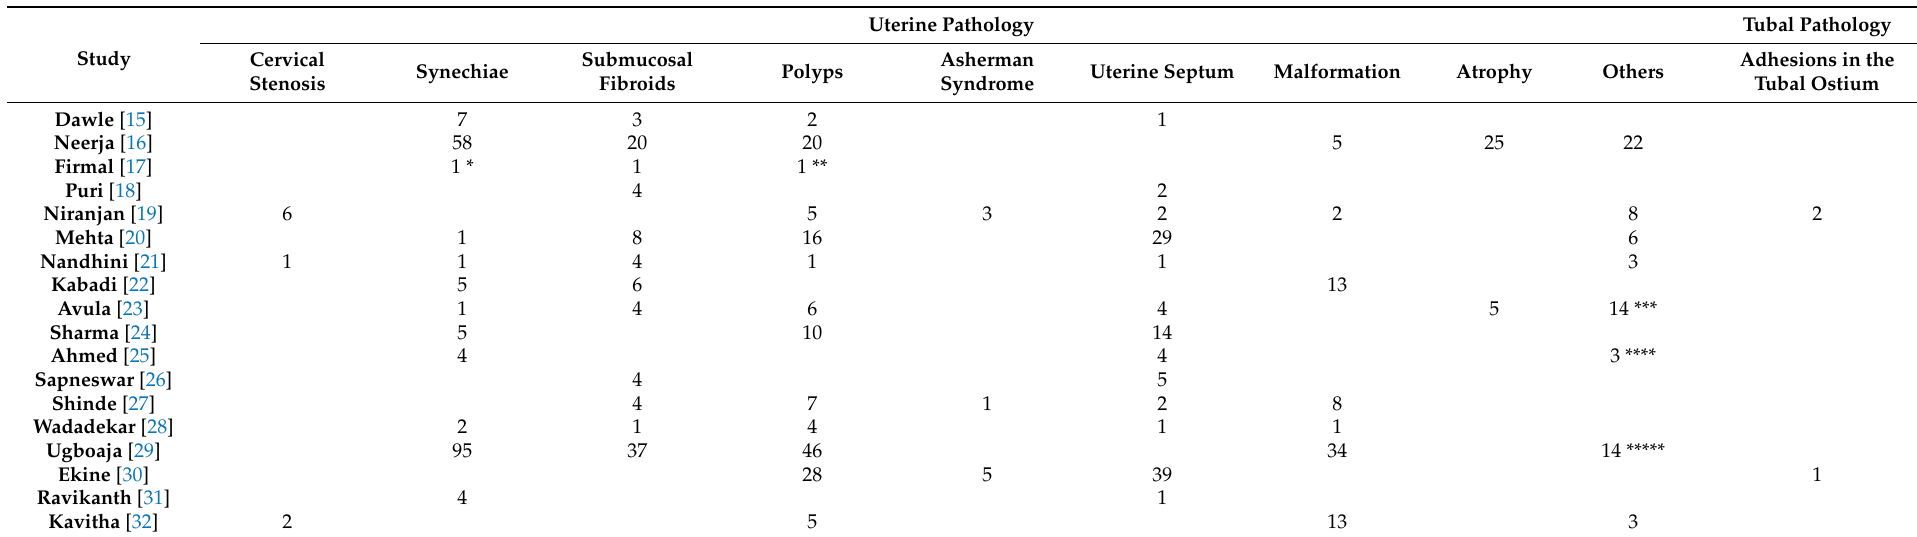
Table 1. Hysteroscopic